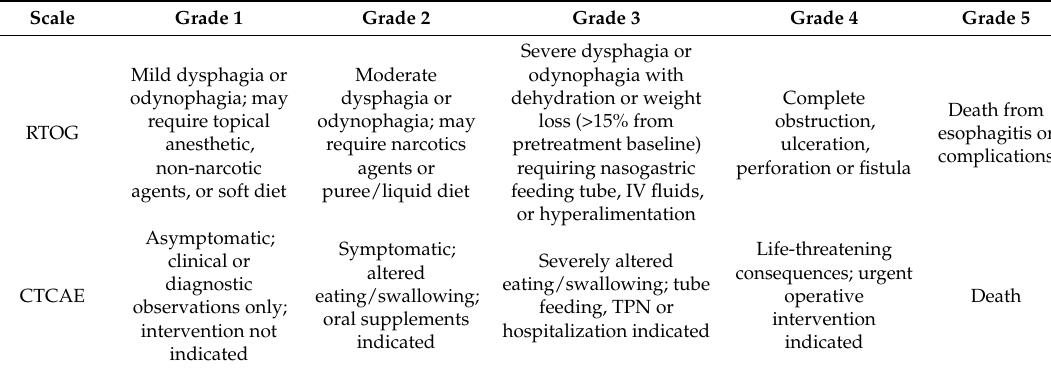
Table 1. Commonly-utilized esophagitis grading